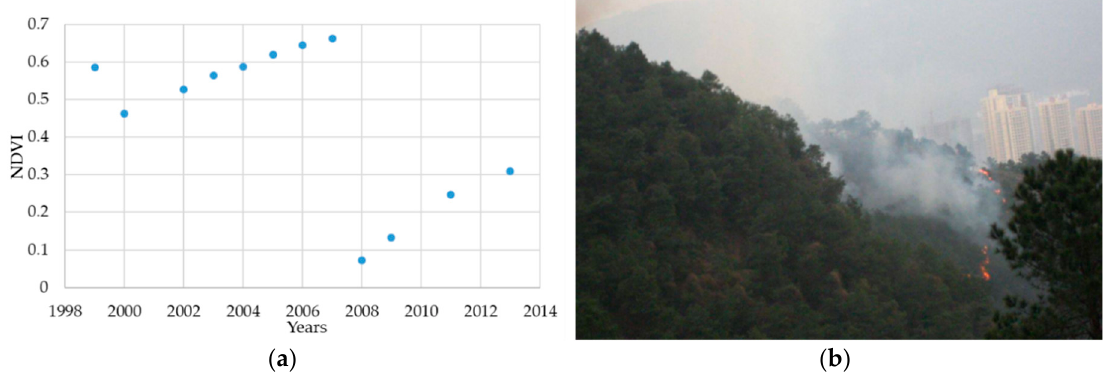
Figure 8. Forest reduction caused by a large-scale fire in alpine bays in Fuling District: ( a ) Mean NDVI trend in the sample area; ( b ) Image of the fire site acquired on February 9, 2008.